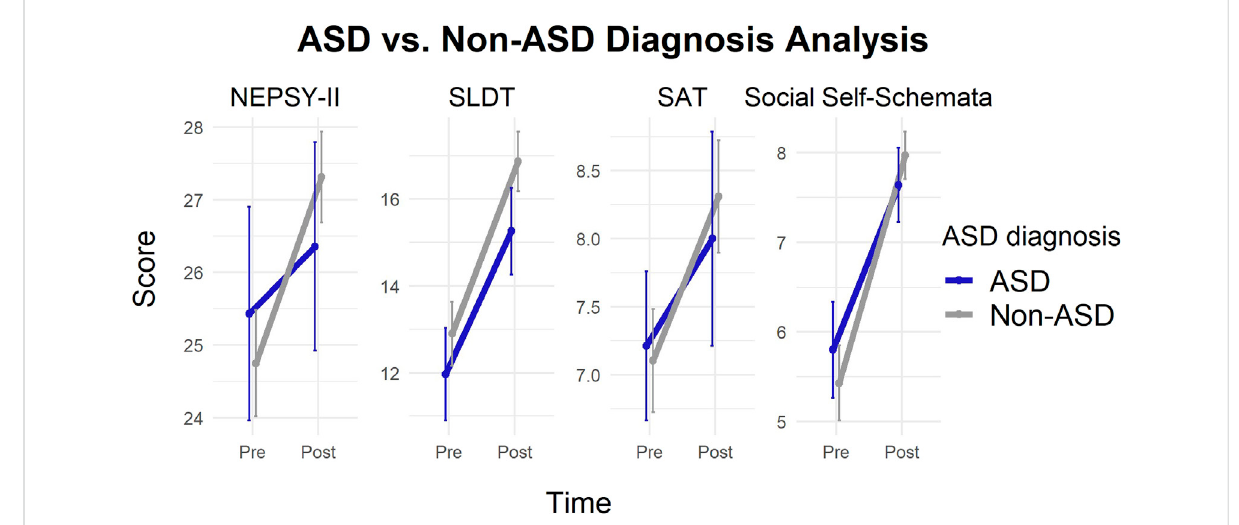
FIGURE 8 Changes in assessment task scores in participants with ASD vs non-ASD. Emotion recognition (NEPSY-II), social inferencing (SLDT), social attribution (SAT), and social self-schemata increased from pretest to posttest in the same manner in participants regardless of diagnosis